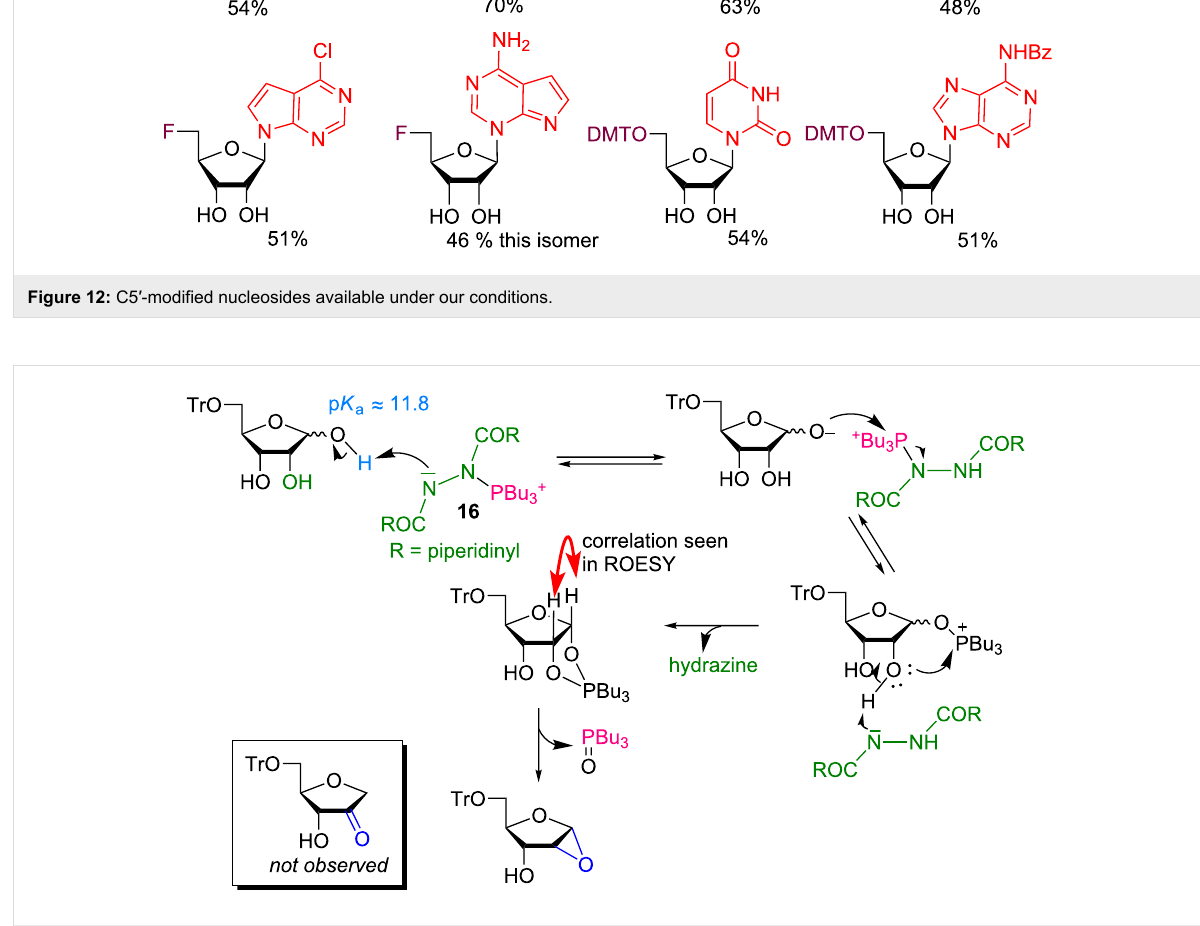
Scheme 40: Plausible reaction mechanism for the formation of the